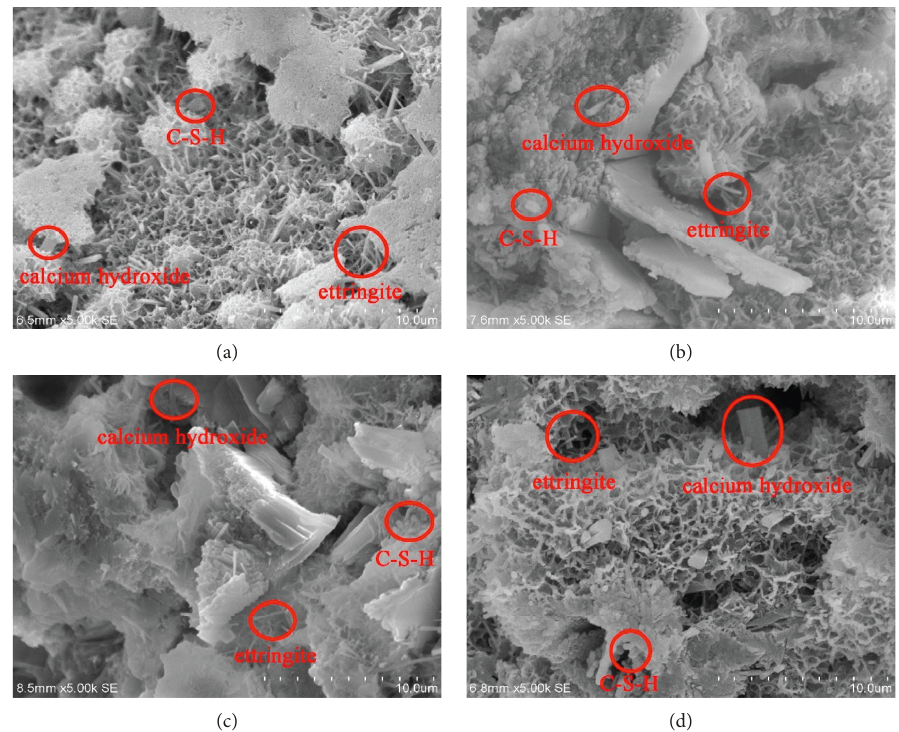
Figure 10: SEM images of FMLSB samples at a 5000x magnification. (a) Level 1 (BTcontent � 50kg/m 3 ). (b) Level 2 (BTcontent � 100kg/m 3 ). (c) Level 3 (BT content � 150kg/m 3 ). (d) Level 4 (BT content � 200kg/m 3